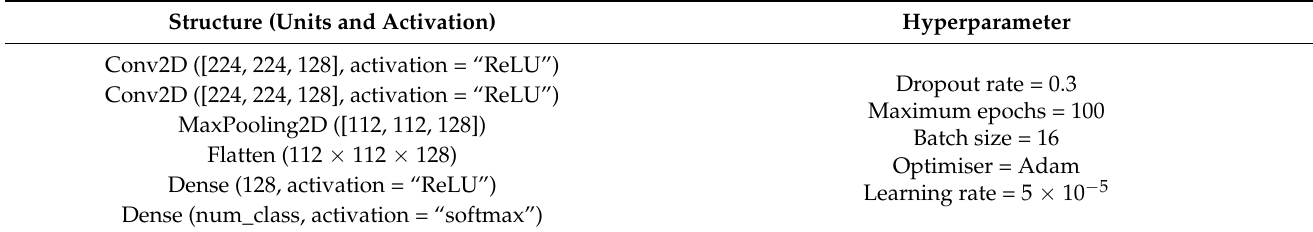
Table 3. Structure and hyperparameter selection for the multifeature fusion CNN